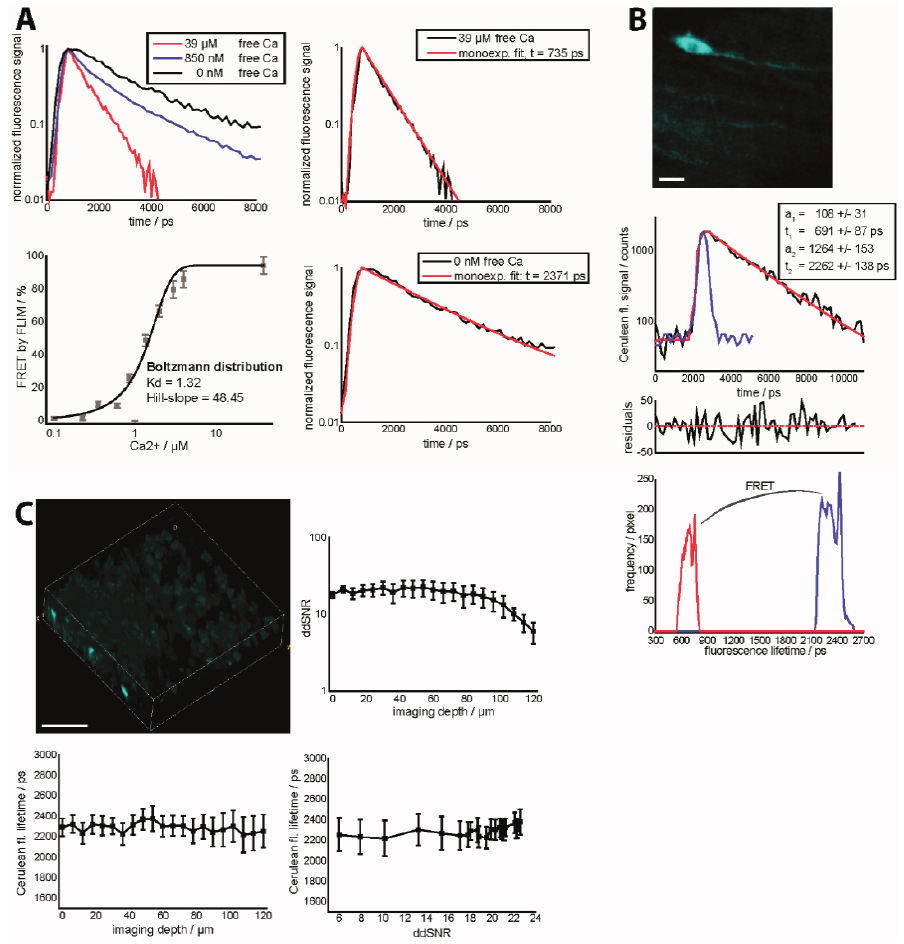
Figure 4. ( A ) Fluorescence decay curves ( right , top ) of the isolated construct TN L15 at 0 nM, 850 nM and 39 µM free calcium. The extreme conditions, i.e. , 0 nM and 39 µM free calcium are additionally mono-exponentially approximated ( left , top and bottom ). Calibration curve of the biexponential FLIM-FRET ratio of the isolated construct TN L15 at various free calcium concentrations ( right , bottom ). a 1 and a 2 are the relative concentrations of FRET-quenched and unquenched Cerulean as given by the biexponential model of the fluorescence decay curve (Supplementary Material); ( B ) Fluorescence signal of Cerulean of a 150 × 150 × 20 µm 3 (256 × 256 × 11 voxel) in the brain stem of a healthy CerTN L15 mouse (intravital measurement). The graph in the middle depicts an example of a decay curve in one of the brightest pixels of the image, including the biexponential approximation curve reconvolved with the instrument response function (blue curve), together with the final parameters and the corresponding residuals. The lowest graph shows the distributions of the fluorescence lifetimes of unquenched and FRET-quenched Cerulean over the 3D image at the top. Scale bar = 25 µm; ( C ) 3D fluorescence intensity image of Cerulean ( right , top ) in a healthy (live) brain slice of a CerTN L15 mouse (300 × 300 × 120 µm 3 , 517 × 517 × 40 voxel). ddSNR curve ( left , top ) as well as corresponding dependence of Cerulean fluorescence lifetime on imaging depth ( right , bottom ) and ddSNR ( left , bottom ). Detection at λ em = 460 ± 30 nm. Excitation at λ exc = 850 nm, mean laser power 8